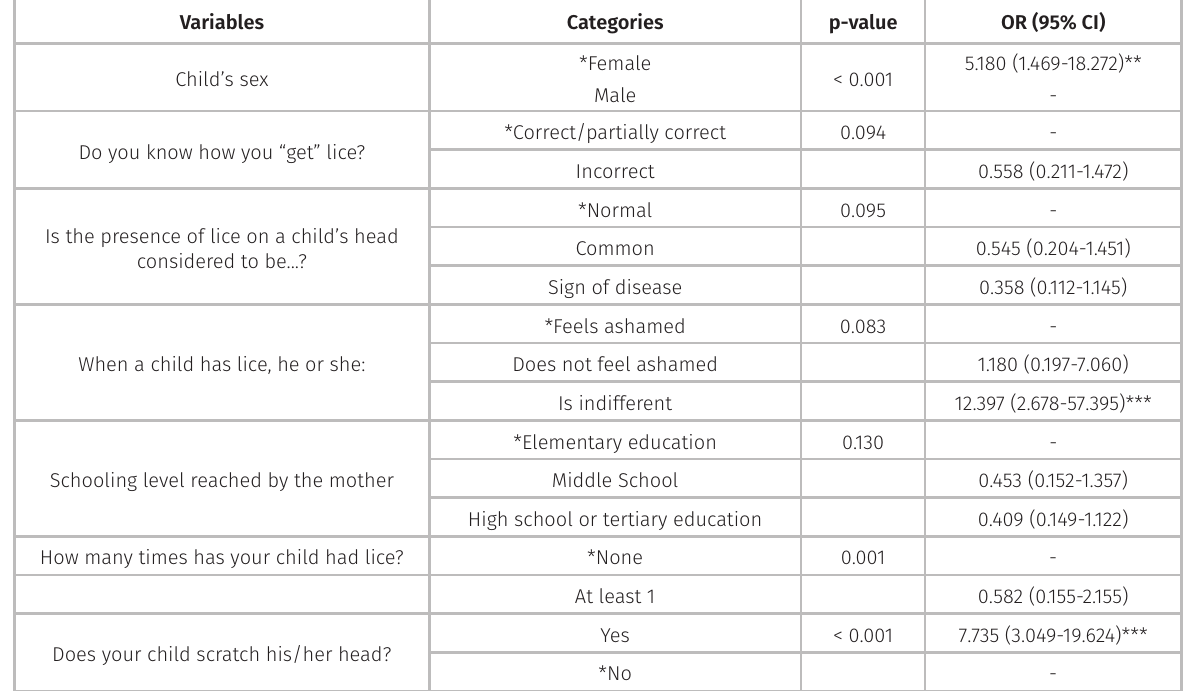
Incorrect 0.558 (0.211-1.472)